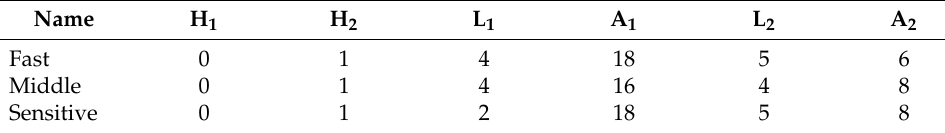
Figure 5. Accuracy and CPU time for each method. Table 4. Parameter details of representative TSSS